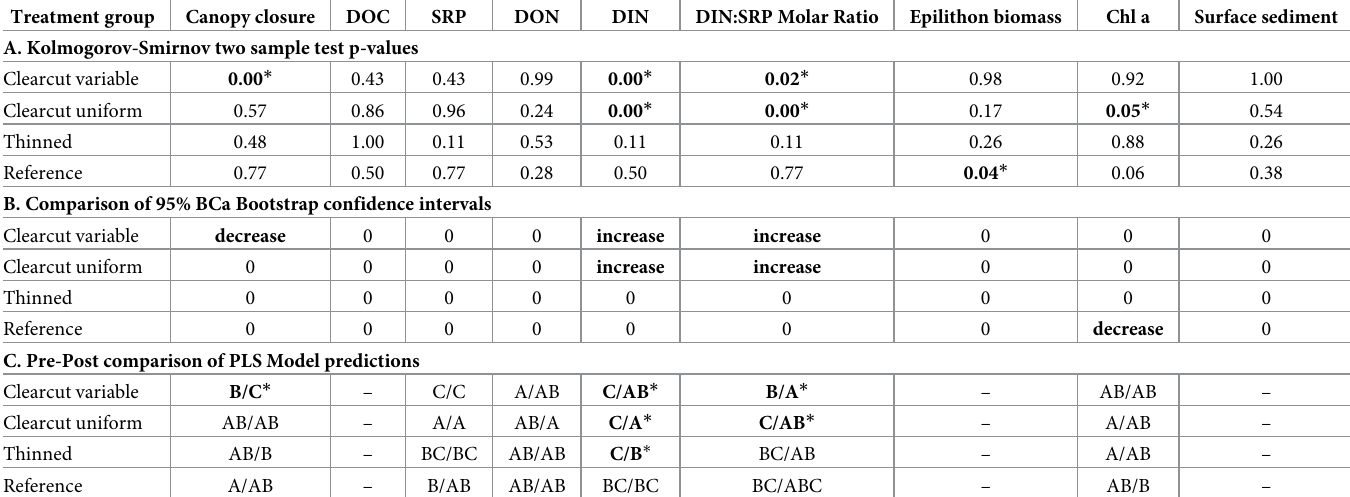
Table 2. Statistical differences between pre- and post-harvest periods for headwater treatment groups.